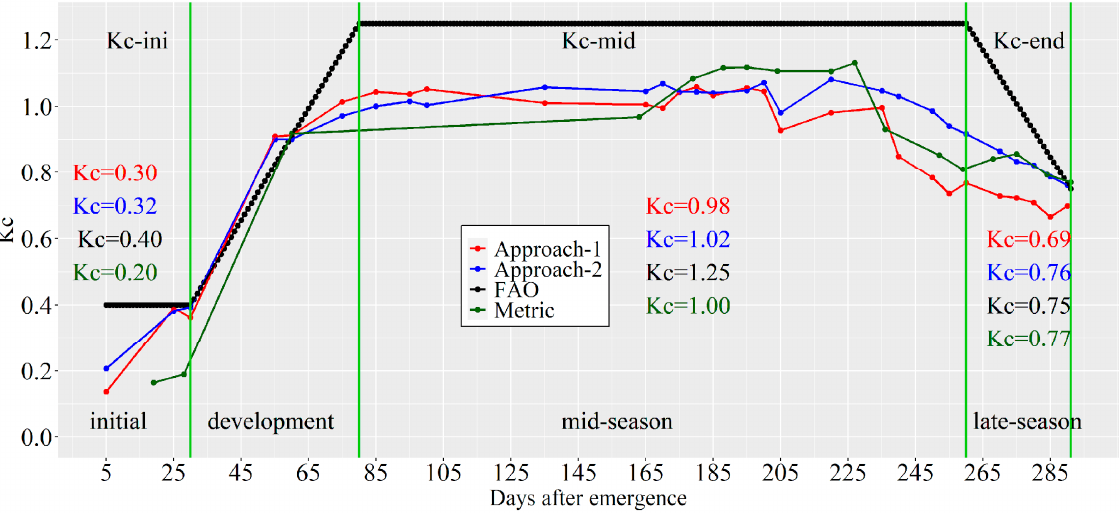
Figure 10. Comparison of K c values between approaches 1 and 2, METRIC, and the ones recom- mended by the FAO’s 56 reports.